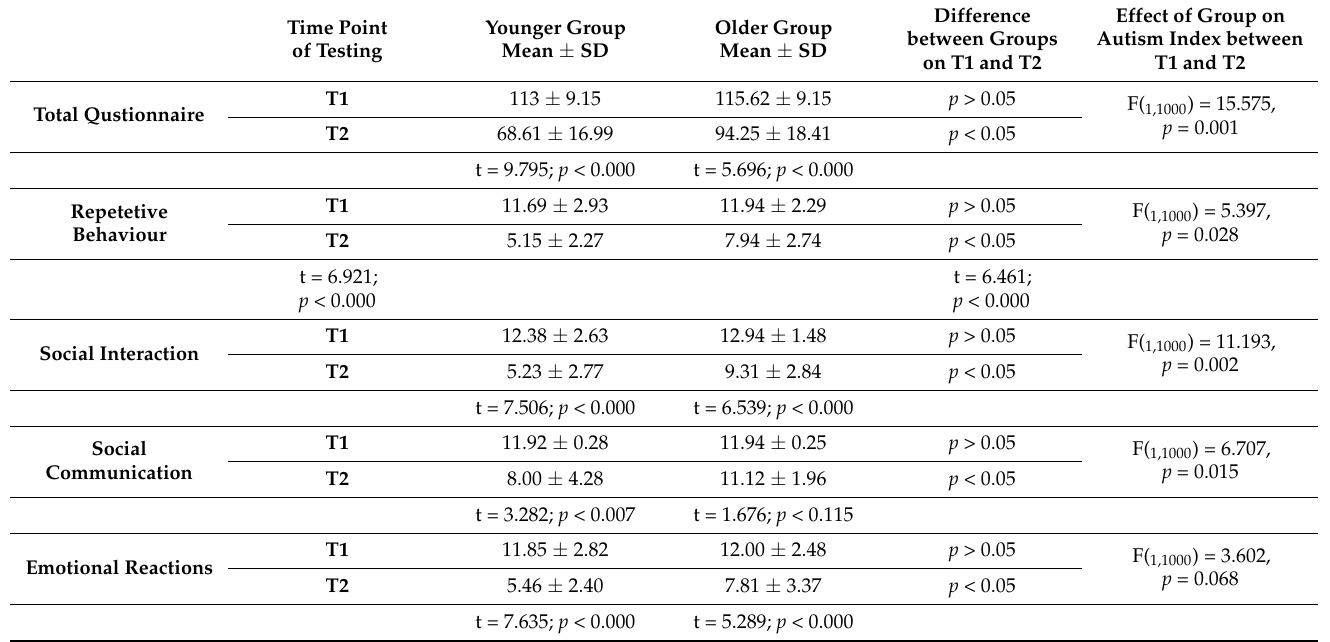
Table A1. Results of GARS-3 regarding Autism Index for total questionnaire and each subscale